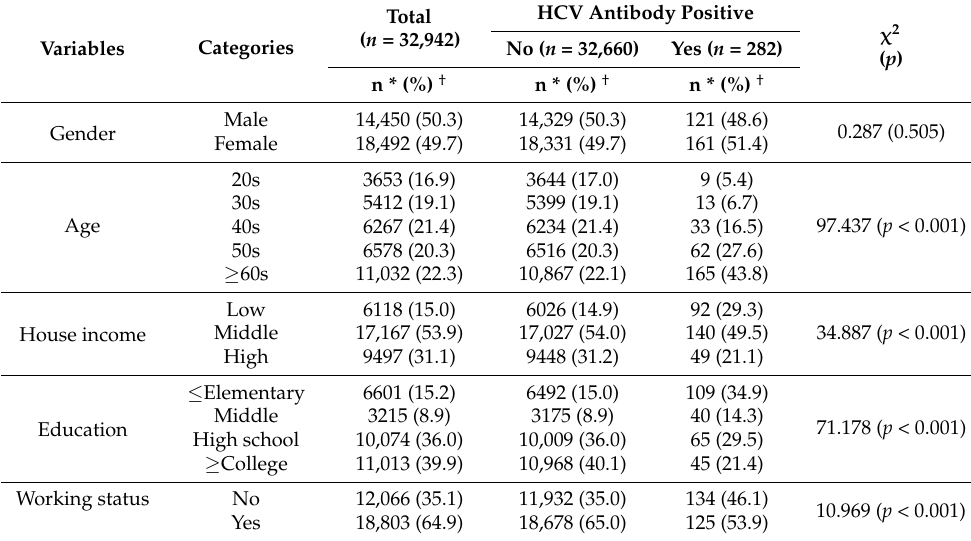
Table 1. Differences in HCV antibody status of Korean adults by socio-demographic characteristics.